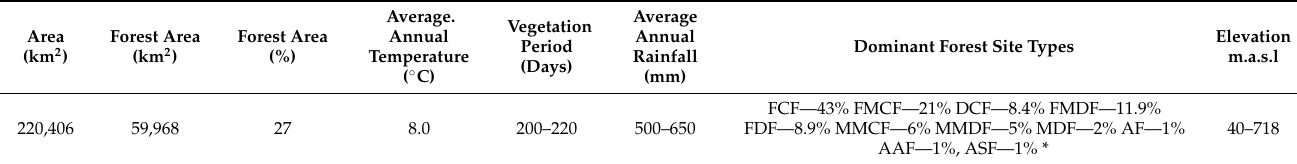
Table 1. Characteristics of the study area